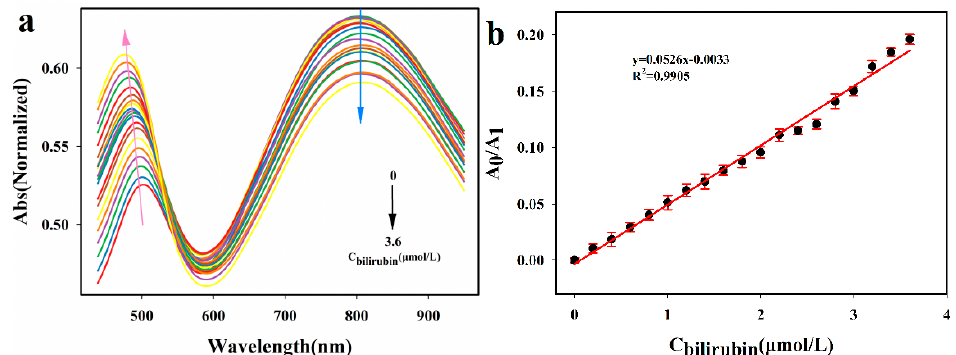
Figure 5. Absorption spectra of GNCs responding to different concentrations (0.2, 0.4, 0.6, 0.8, 1, 1.2, 1.4, 1.6, 1.8, 2, 2.2, 2.4, 2.6, 2.8, 3, 3.2, 3.4, 3.6 μ mol/L) of bilirubin ( a ) and the linear response curve ( b )